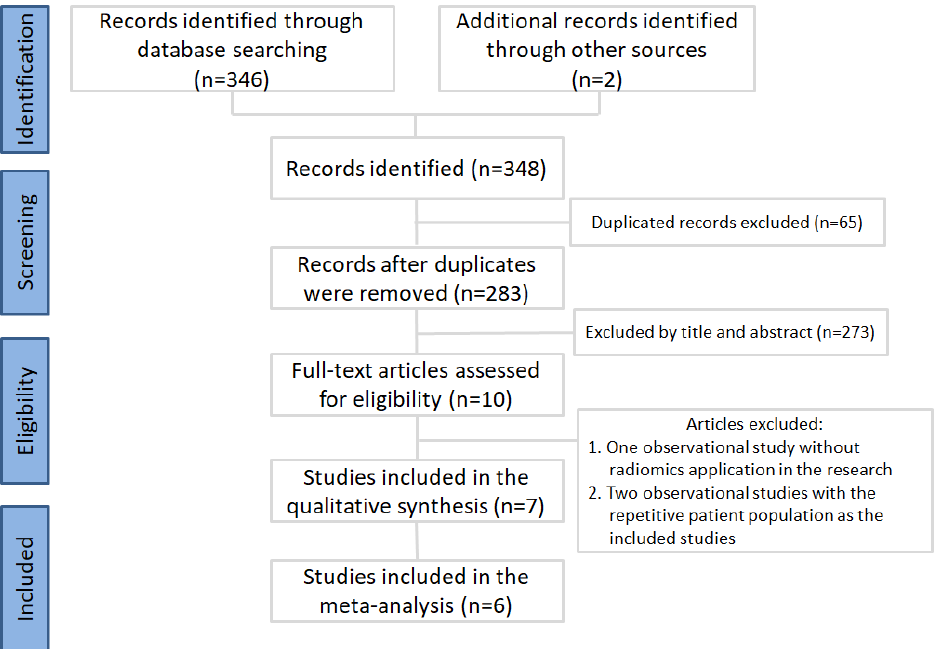
Figure 1. Inclusion process for the identified studies.